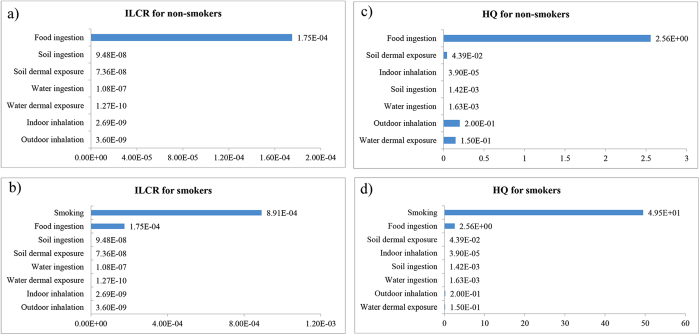
Multi-pathway analysis of ILCRs and HQs in non-smokers and smokers.(a) ILCR for non-smokers. (b) ILCR for smokers. (c) HQ for non-smokers. (d) HQ for smokers.